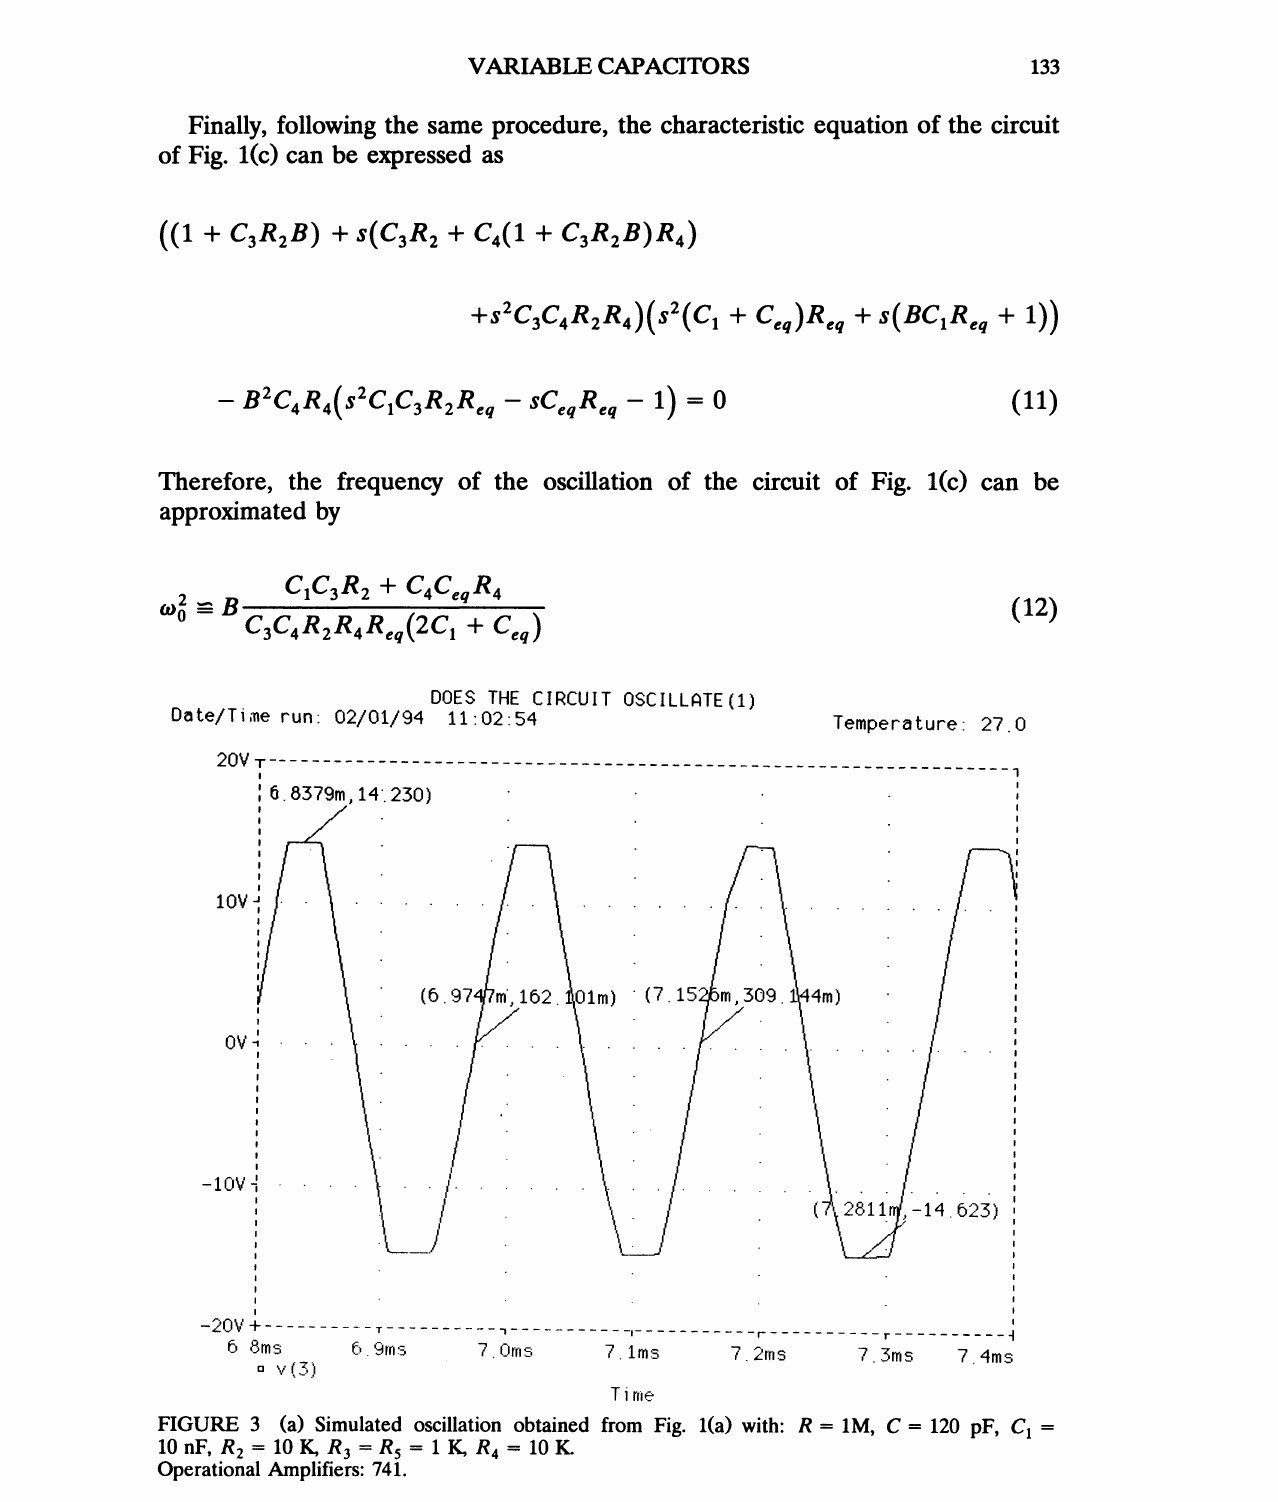
FIGURE 3 (a) Simulated oscillation obtained from Fig. l(a)with: R 1M, C 120 pF, C 10 nF, R 10 K, R R K, R 10 K. Operational Amplifiers: